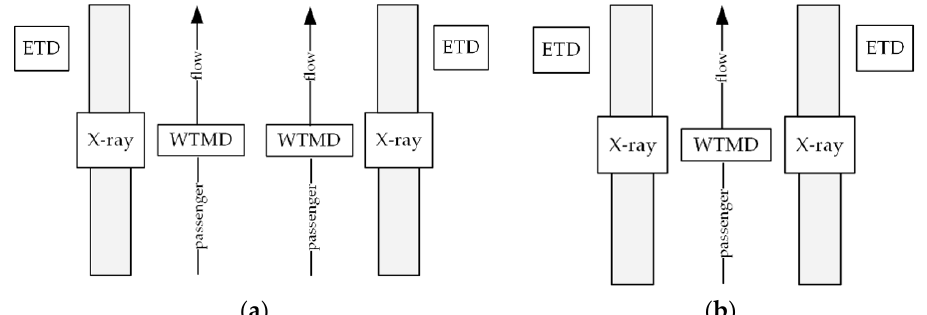
Figure 2. Comparison of systems with: ( a ) two single lanes, ( b ) one double lane.